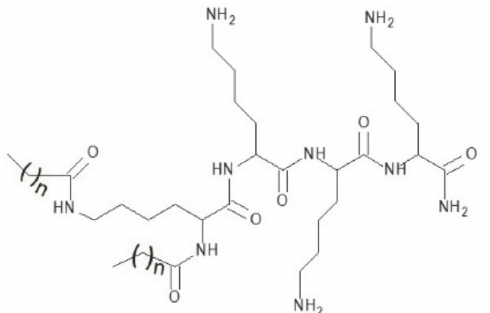
Figure 1. Molecular structure of the lipopeptides (C 10 ) 2 -KKKK-NH 2 ( n = 8) and (C 12 ) 2 -KKKK-NH 2 ( n =